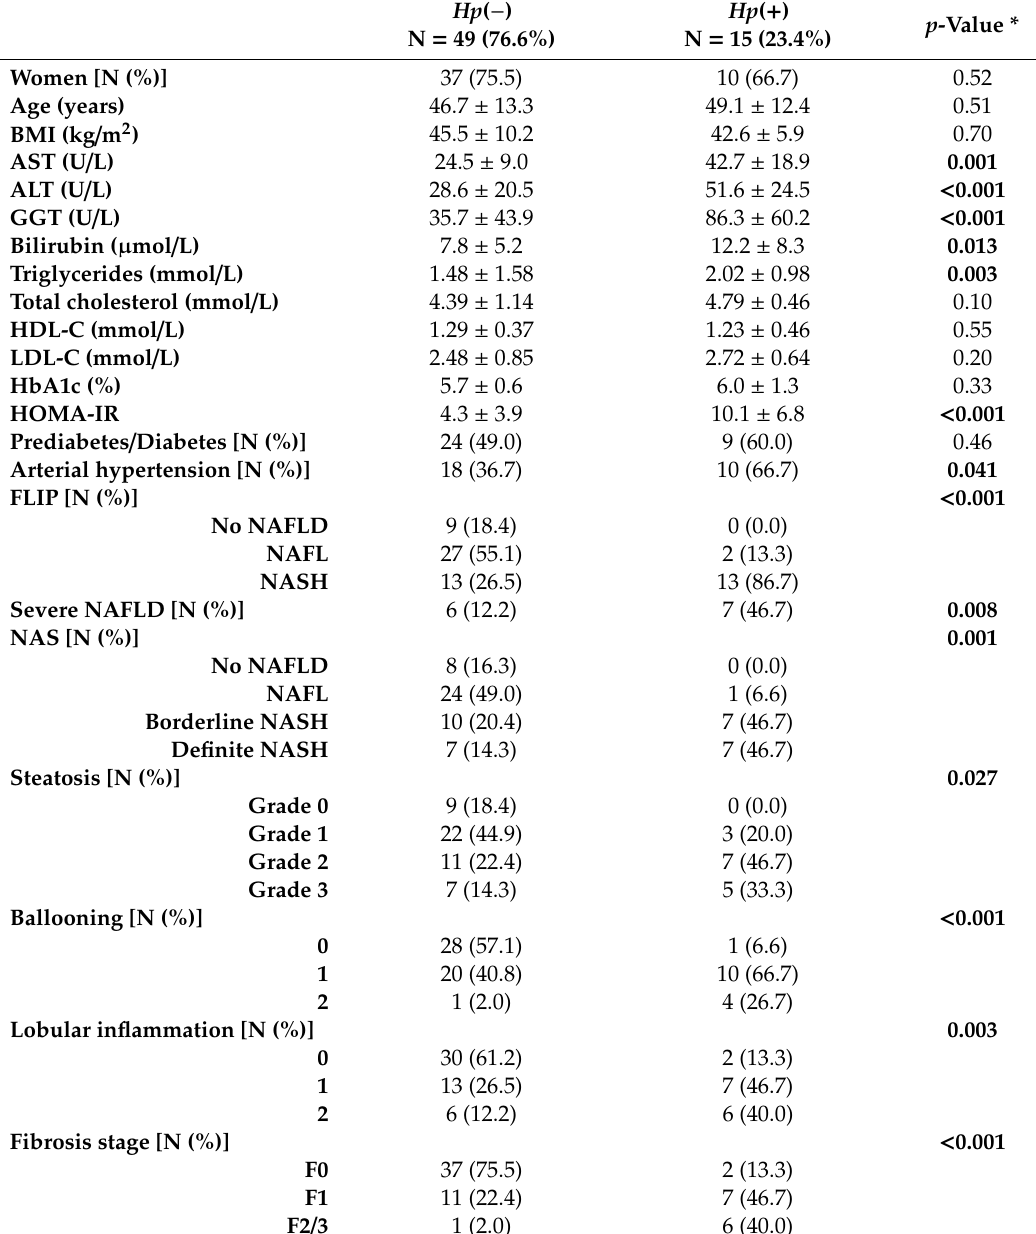
Table 1. Comparative data between Hp ( + ) and Hp ( − )